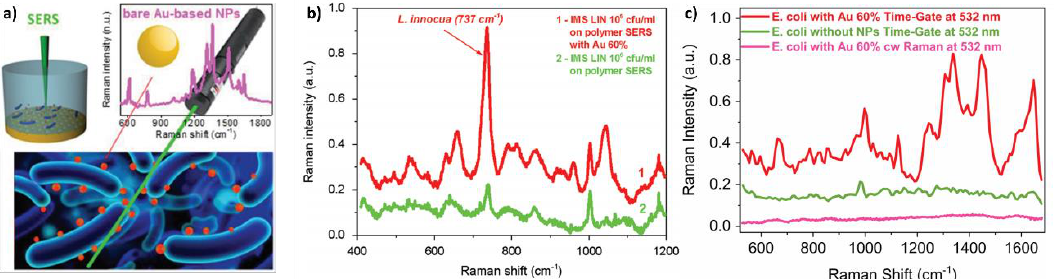
Figure 9. ( a ) Schematic description of the research carried out. ( b ) Normalized surface-enhanced Raman scattering (SERS) spectra of immunomagnetic separation (IMS) bead captured L. innocua (IMS LIN) detected using a polymer-based SERS substrate (green) and a combination of the substrate and Au-60% NPs (red) using 785 nm CW excitation. ( c ) SERS spectra of E. coli W3110 measured with time-gated Raman using 532 nm wavelength picosecond pulsed excitation with the use of Au-60% NPs as Raman probes (red) and without them (green). For comparison the Raman spectra without time gating (pink) is shown. (Reproduced with permission from [117]. John Wiley & Sons, 2018).